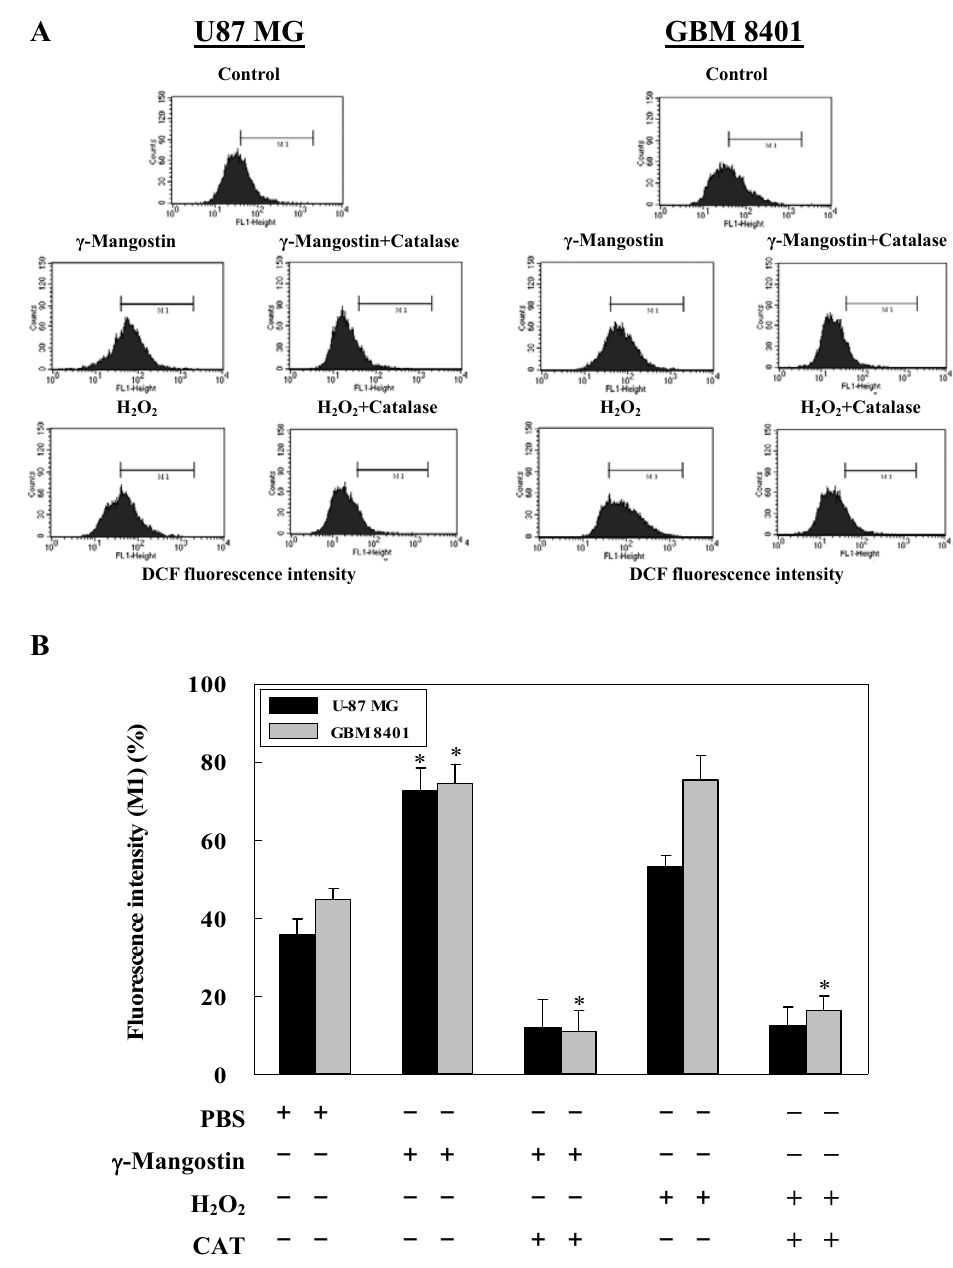
Figure 3. Increased intracellular peroxide levels in γ -mangostin treated U87 MG and GBM 8401 cells. (A) Cells were treated with γ -mangostin (80 μ M) or H with or without prior treatment with catalase (CAT; 400 U / mL) for 30 min. At the end of the reaction, the level of intracellular peroxide was examined by adding DCHDA for an additional 30 min followed by a flow cytometric analysis. (B) γ -Mangostin induced the intracellular peroxide, which was measured quantitatively through the intensity of DCFDA (DCF fluorescent intensity), by 50% compared to the untreated cells region (M1) of the control group on both cell lines. Data derived from three independent experiments were calculated statistically, and results are presented as the mean ± SD. * p < 0.05 and ** p < 0.01 indicate significant differences from the control group as analyzed by Student’s t